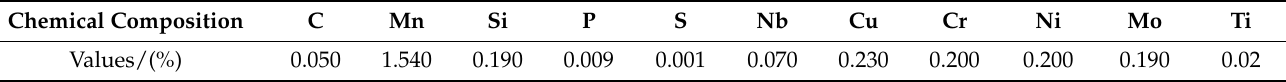
Table 1. The main chemical composition of X70 pipeline steel (wt.%).